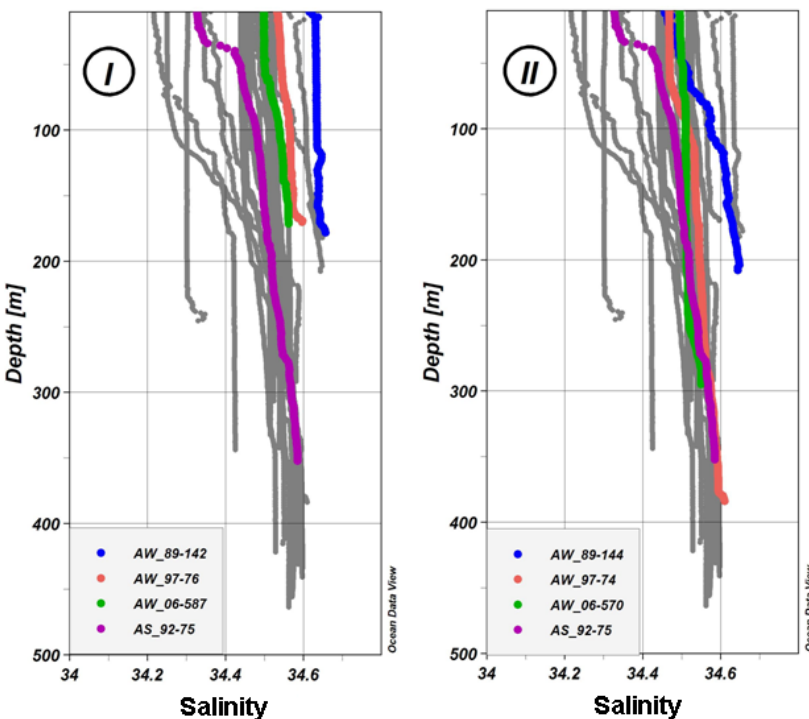
Fig. 8. Austral winter salinity profiles from the shallow ( < 500m) northwestern Weddell Sea continental shelf for cruises AW 89, AW 97, and AW 06, in gray, together with selected stations from the areas I and II (Fig. 1b), sampled during 1989 (blue), 1997 (red), and 2006 (green). In addition, a characteristic profile from the continental shelf south of Larsen C Ice Shelf (purple) measured during cruise AS 92. See Fig. 1a for station